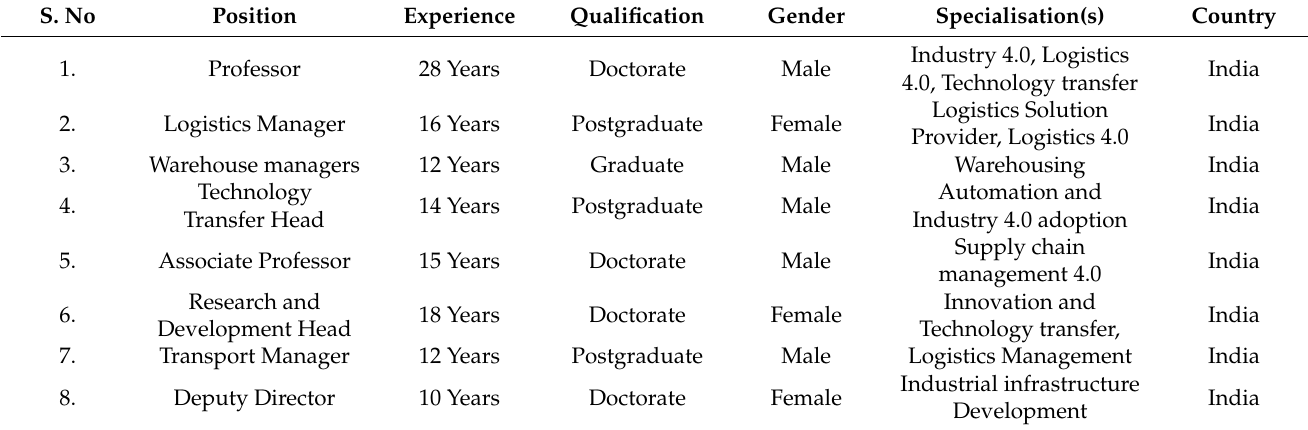
Table A1. Details of the participated